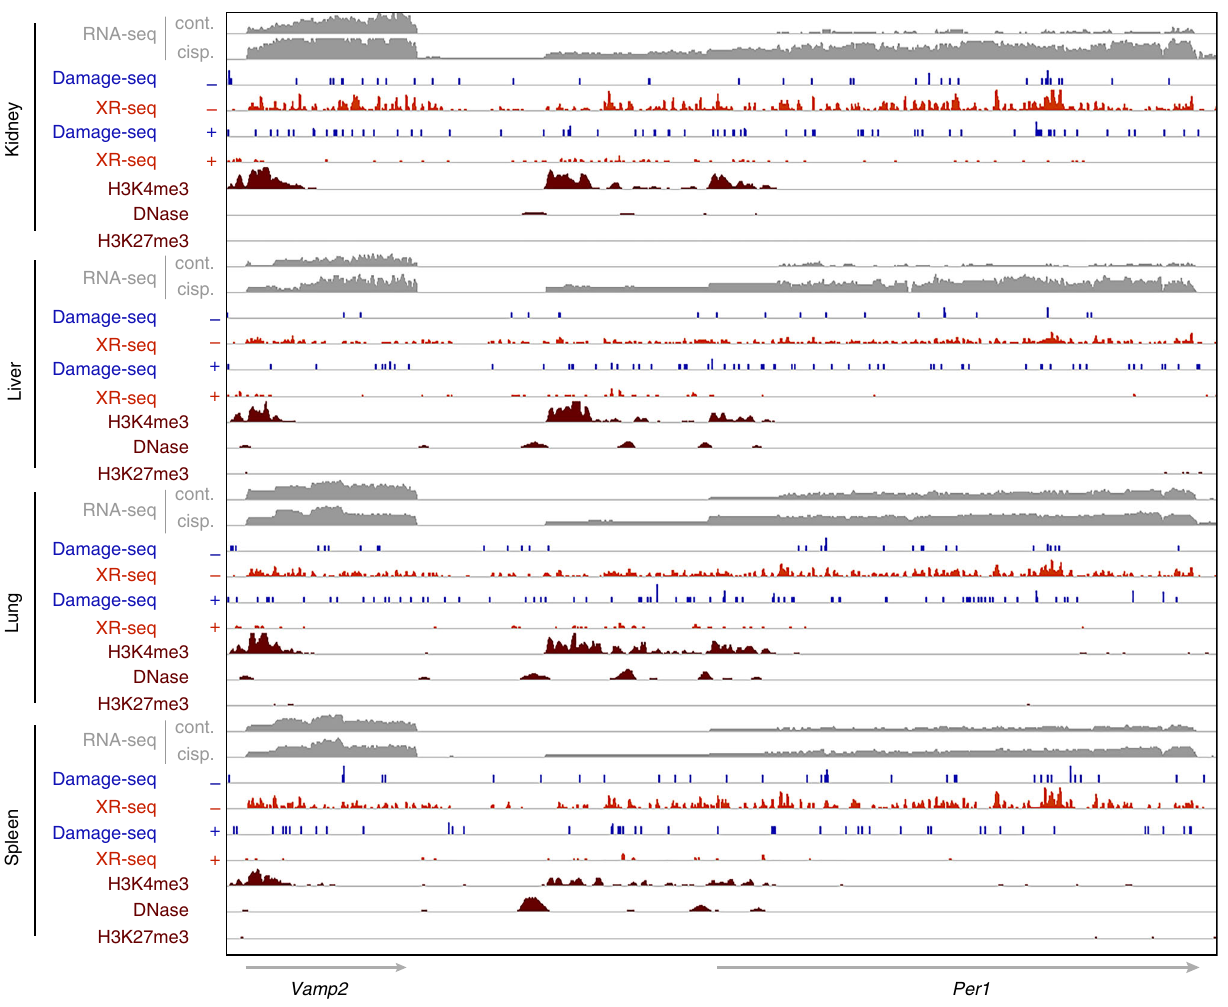
Fig. 5 DNA damage, repair, gene expression, and epigenomic markers for Per1 . Per1 is signi fi cantly upregulated after cisplatin treatment across all four organs. Damage-seq and XR-seq data are shown for both strands. Pt-d(GpG) damage (Damage-seq) and repair (XR-seq) distribution on the TS and NTS are shown with − and + , respectively. Epigenetic data from ChIP-seq of H3K4me3 and H3K27me3, as well as DNase-seq, are plotted at the bottom of each organ section. We show that the transcriptional and epigenomic pro fi les of Per1 and neighboring region across all four organs recapitulate the differences in DNA damage and repair between the TS and